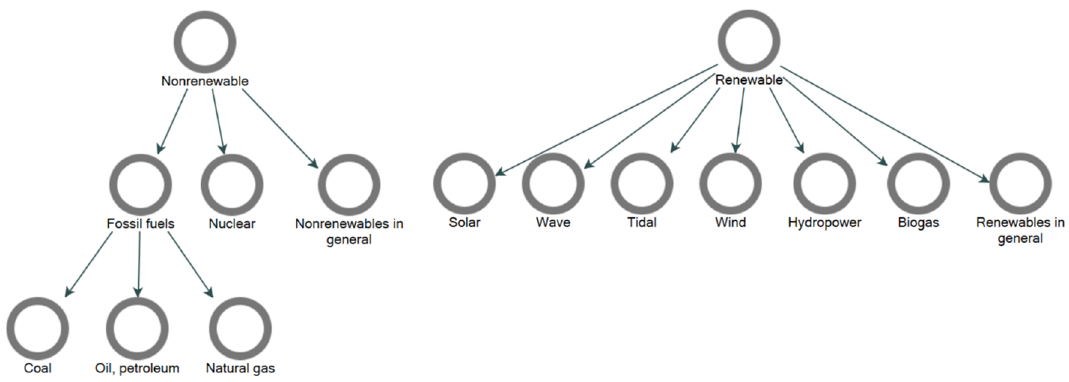
Figure 1. NVivo map of keywords concerning nonrenewable and renewable energy sources.